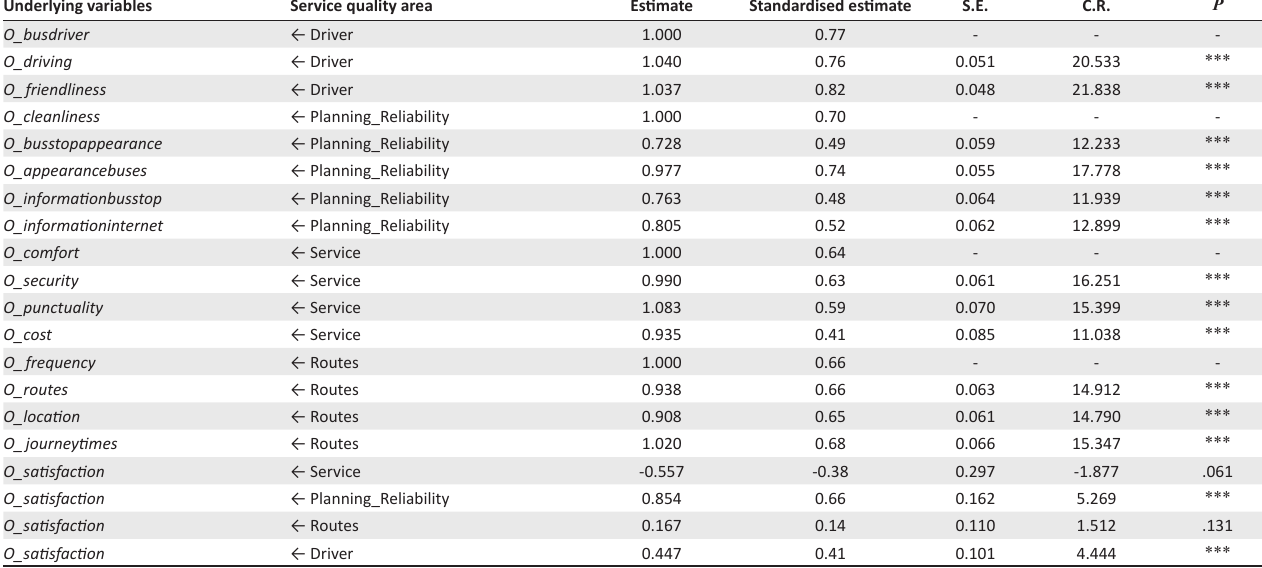
TABLE 7: Initial model attribute estimation and significance levels. Underlying